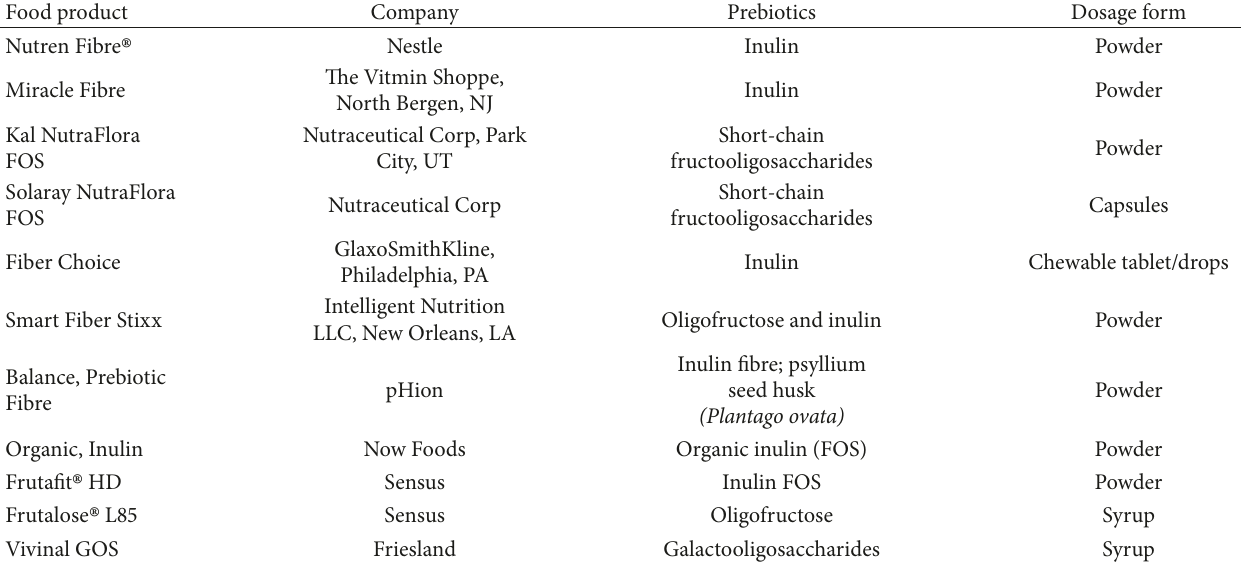
Table 2: Example of marketed prebiotics